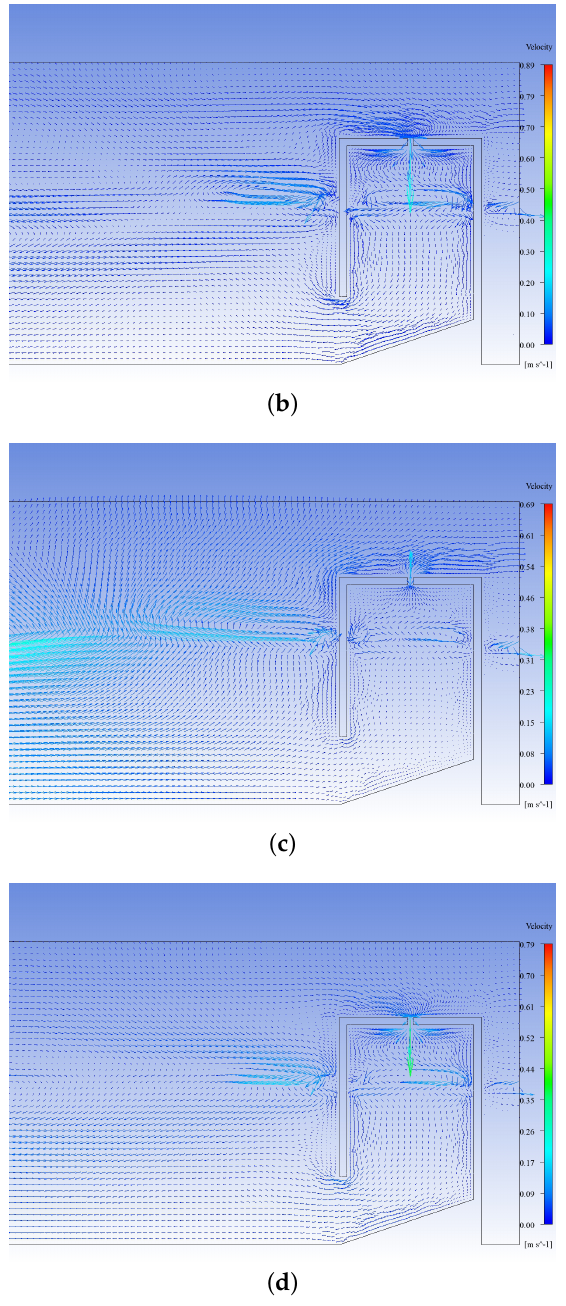
Figure 4. Velocity-vector profile at various time instants: ( a ) t = 110 s, ( b ) t = 170 s, ( c ) t = 180 s, and ( d ) t = 199 s, with H s = 0.9 m and ω p = 1.257